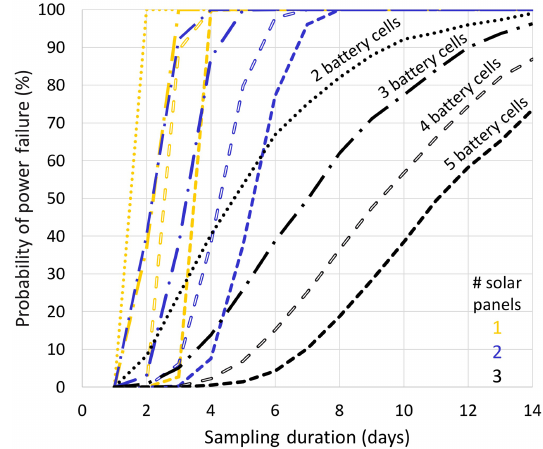
Figure 4. Probability of OAS power failure evaluated for various power designs (number of solar and battery cells) as a function of the number of continuous sampling days. Colors represent the num- ber of solar panels (0.014m 2 each) and line type represents number of Li-ion batteries (10.78Wh each)